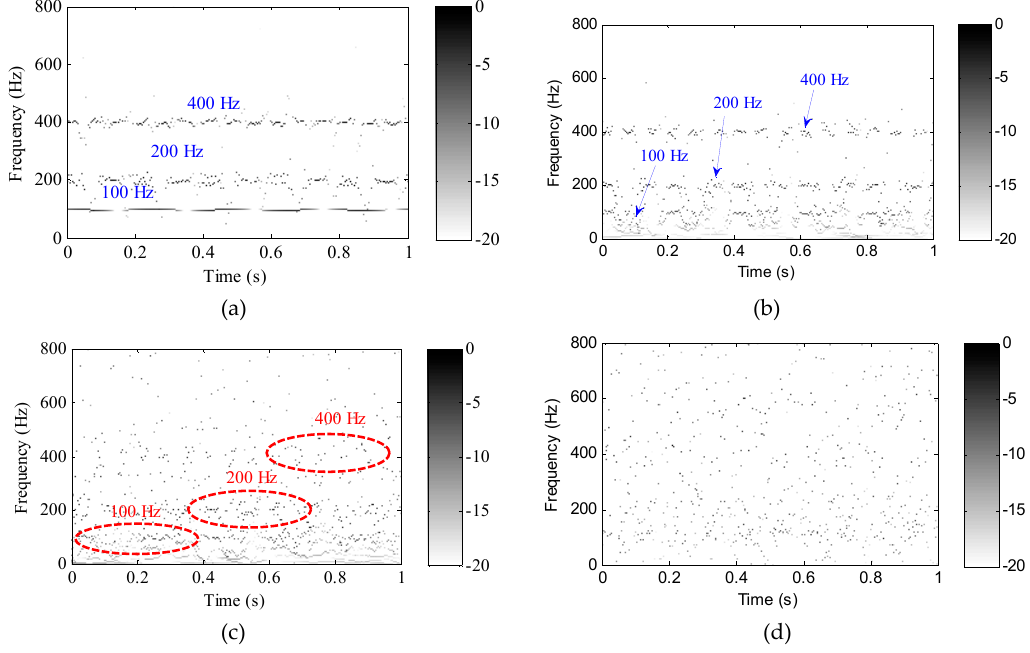
Figure 16. The time-frequency representations obtained by different methods for simulation 2: ( a )